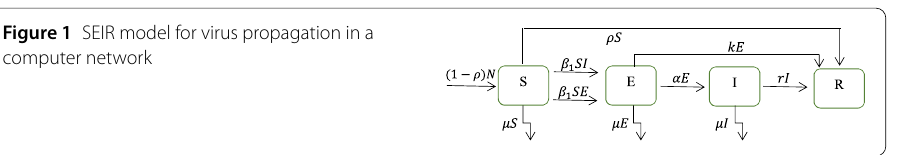
Figure 1 SEIR model for virus propagation in a computer